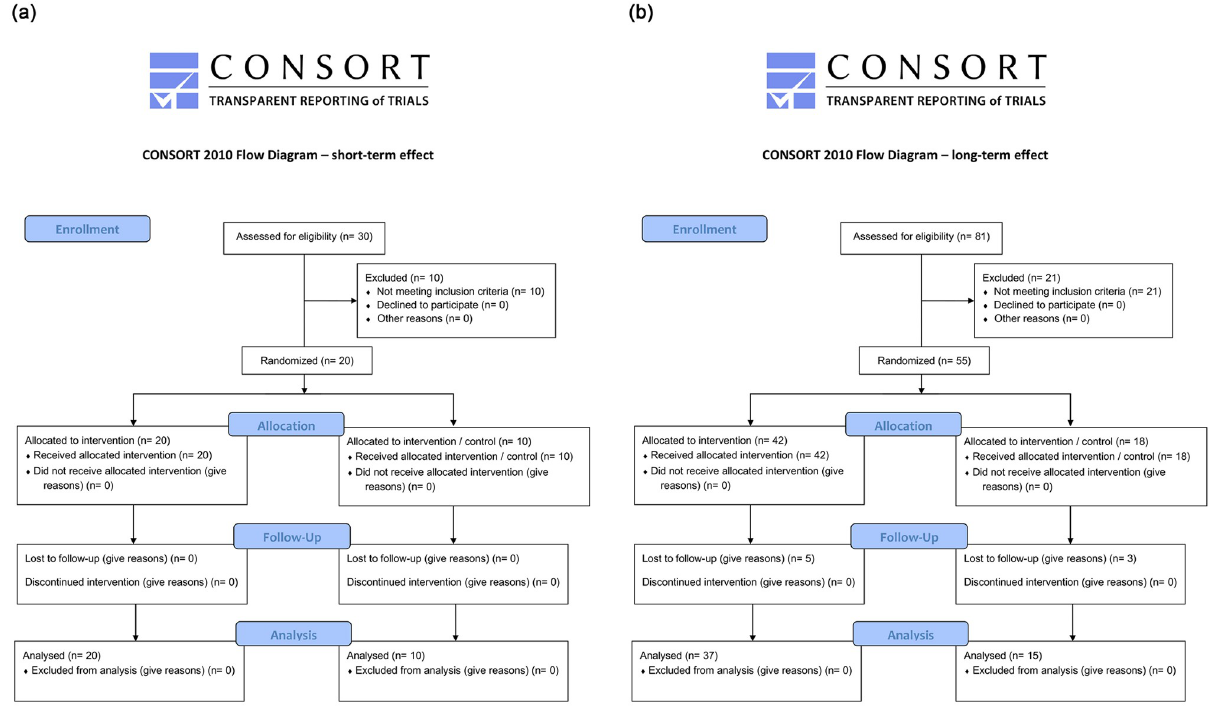
Fig 1. a—CONSORT Flow Diagram for short-term effect group. b—CONSORT Flow Diagram for long-term effect group.